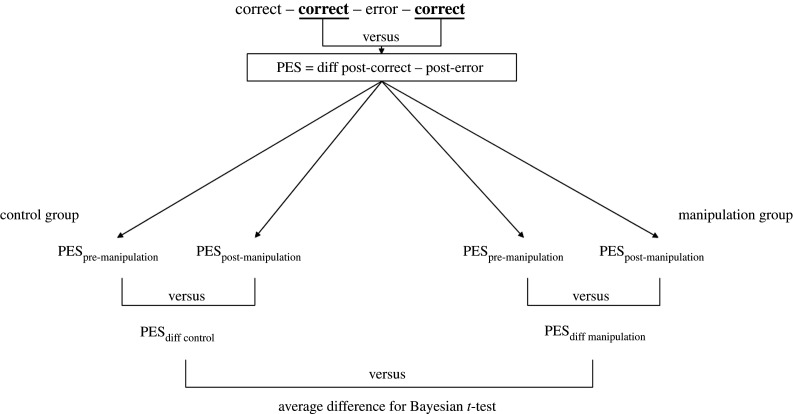
Schematic overview of the Dutilh et al. [27] method to calculate post-error slowing and the planned comparisons.